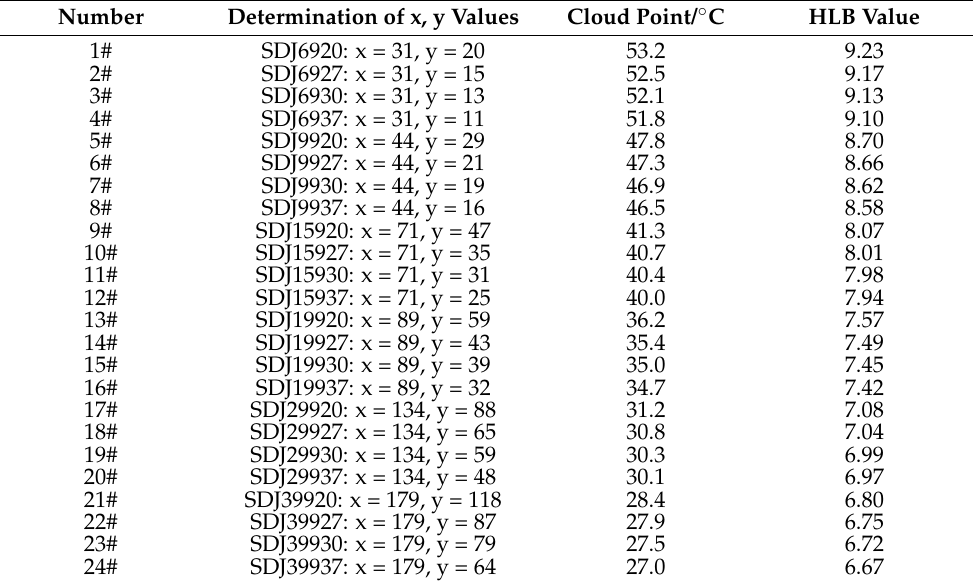
Table 3. Cloud point and HLB value off fluorinated polyether demulsifiers.